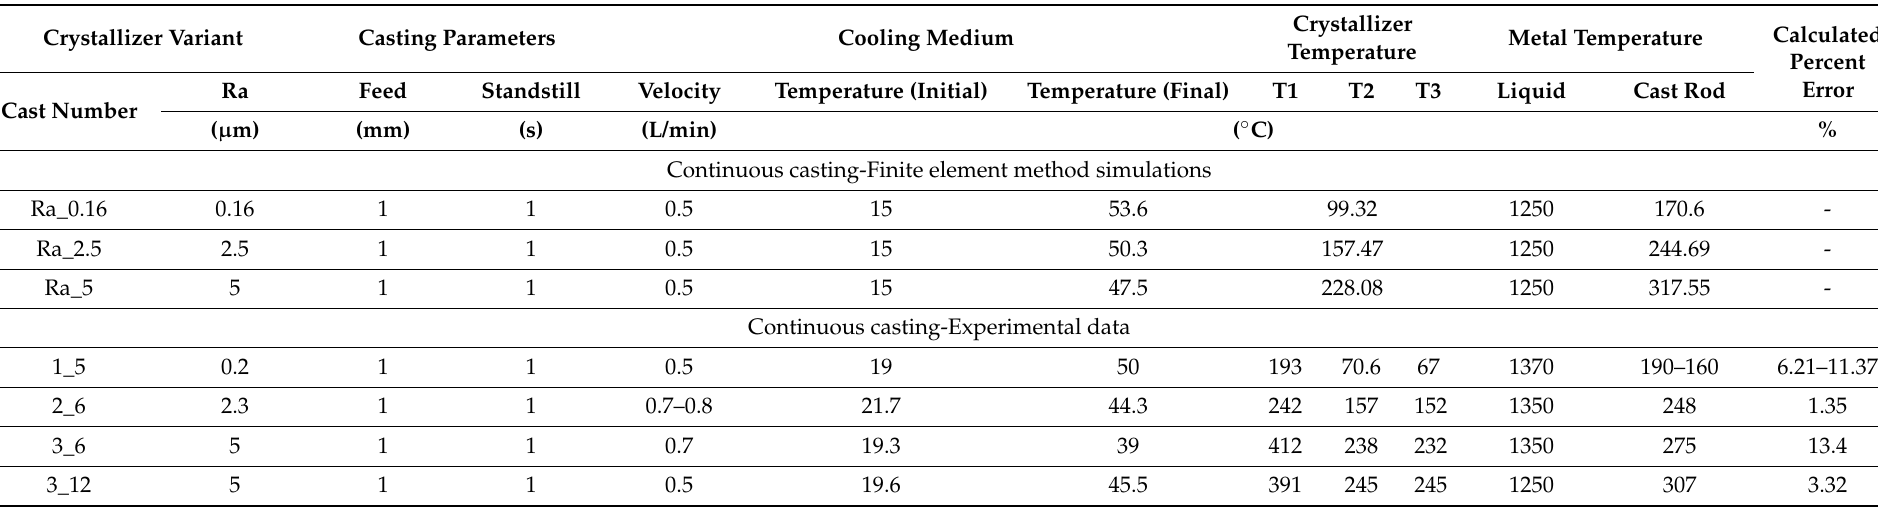
Table 3. Comparison of the obtained data with the finite element method simulation results of the representative